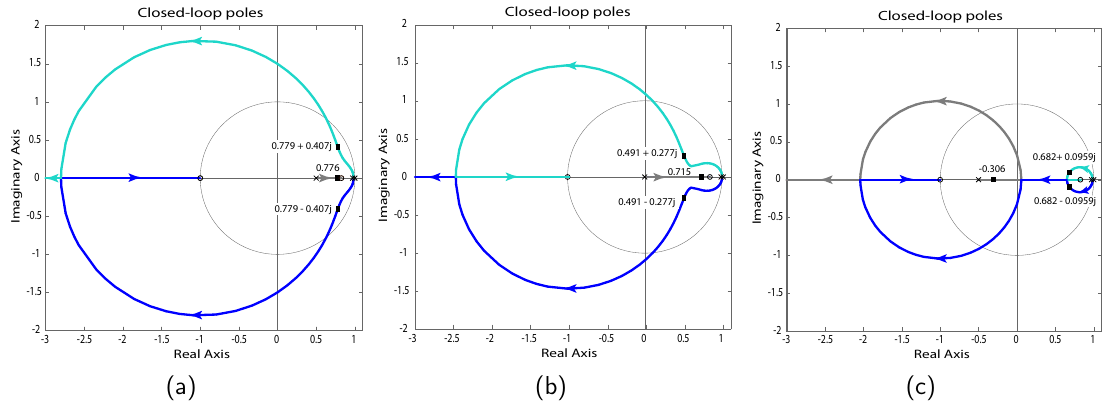
Figure 5. Root locus plots for different current loop convergence factors ( w ) using the same PI as a voltage loop compensator: ( a ) w = 0.5; ( b ) w = 0.0; ( c ) w = 0.5. − − Closed voltage loop simulated and experimental responses to 2-A step changes in the nominal ± load are provided in Figure 6. Left plots correspond to PSIM simulations and right plots to experimental oscillograms. Again, the PI compensator is the same in Equation (46) for all cases shown, being w the only parameter that is different among the lines of subplots. The less damped voltage responses in top Figure 6a,b that correspond to w = 0.5 are qualitatively in good agreement between them and also with the theoretical underdamped closed loop poles of Figure 5a root locus. The amplitudes of the over- and undershoots and frequency of the ringings are similar although the experimental plot seems slightly more damped, which is to be expected because the simulation considers only conduction losses. Middle Figure 6c,d depict the simulated and experimental load regulation responses when w = 0.0. Both voltage responses are a bit more damped than the one expected from a system with